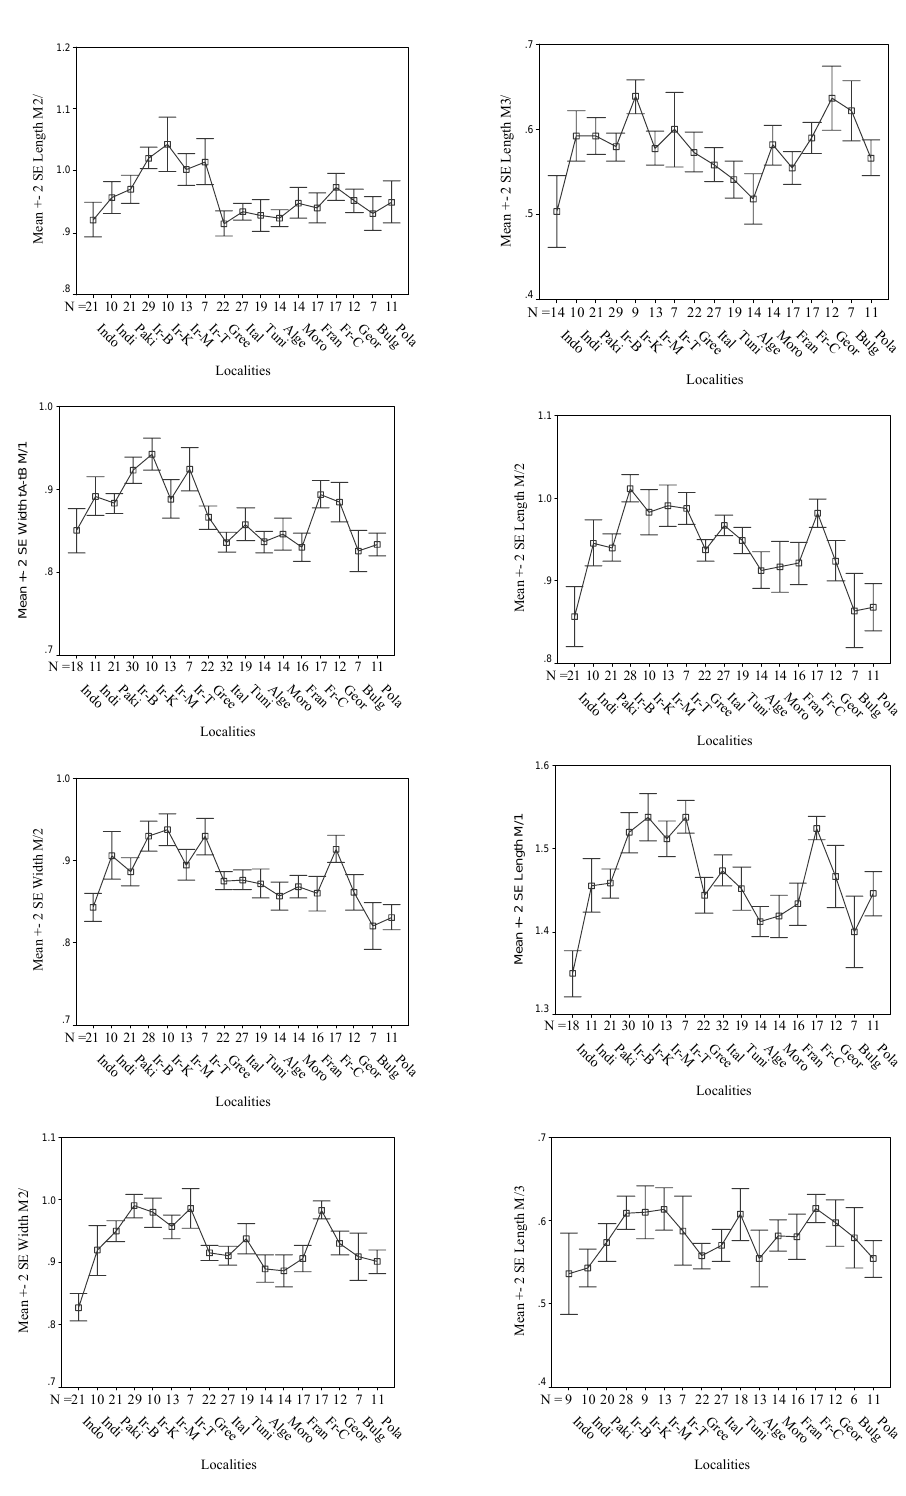
F IG . 4- Mean and standar error variation of 8 morphometric variables of upper and lower molars in house mouse of Idonisia(indo), India(Indi) Pakistan( Paki ), Iran Birjand(Ir-B),Iran Kakhk( Ir-k) , Iran Mashad (Ir-M), Iran Tehran (Ir-T), Georgia (Geor), Greece (Gree), Bulgaria (Bulg), Poland(Pola), France (Fran) , France Corse(Fr-C) , Tunisia (Tuni), Algiria( Alge) and Morocco (Moro).